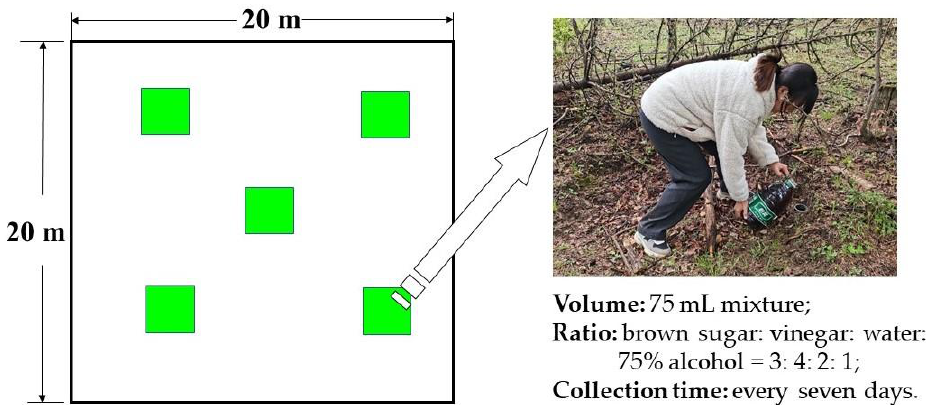
Figure 1. The schema of “pitfall trapping” sampling design.